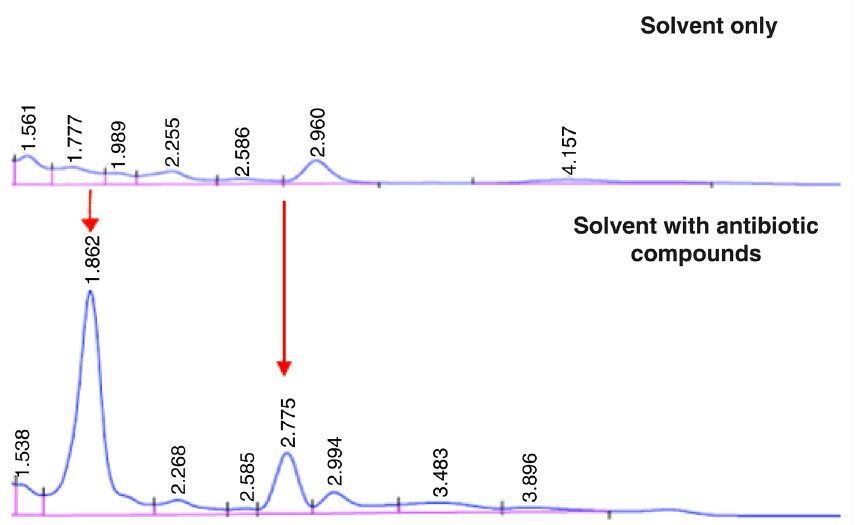
Figure 4. HPLC Chromatographs of organic mursamacin antibiotics. Top chromatograph represents the solvent only while bottom chromatograph is of solvent containing organic mursamacin antibiotics. Two dominant compounds, indicated by the red arrows, were detected in this